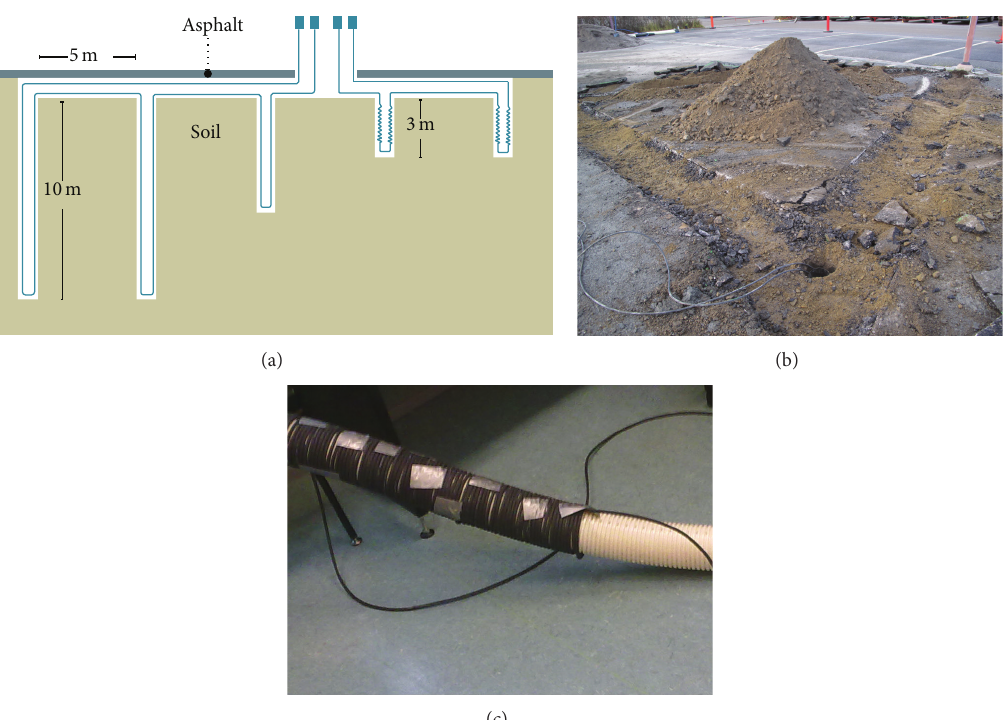
Figure 5: (a) This basic diagram indicates drilled holes in the asphalt pavement. (b) Installing cable to a 10m hole. (c) The wrapping of cables for 3 m deep holes.